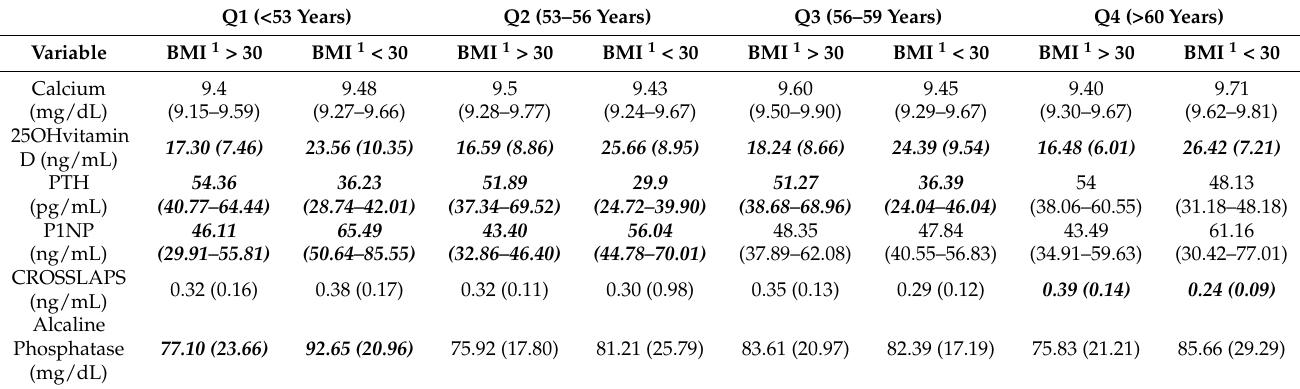
Table 2. Differences in bone metabolism biochemical markers between BMI agruped by age